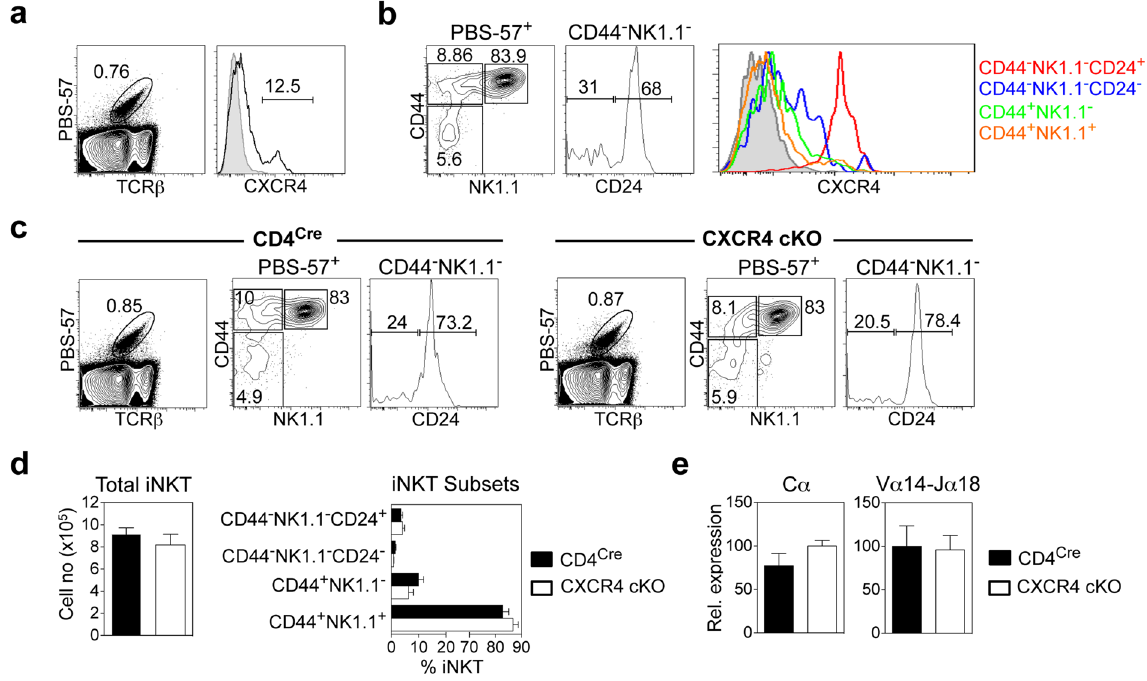
Figure 4. Intrathymic iNKT cell Development In CXCR4 cKO Mice. ( a ) Representative expression of CXCR4 by PBS-57 + CD1d-restricted thymocytes from WT mice. ( b ) Representative expression of CXCR4 by populations of PBS57 + thymic iNKT cells, defined as CD44 − NK1.1 − CD24 + , CD44 − NK1.1 − CD24 − , CD44 + NK1.1 − , and CD44 + NK1.1 + . Grey histograms show isotype control staining for CXCR4. ( c ) FACS analysis of total and iNKT cell subsets in control CD4 Cre and CXCR4 cKO mice. ( d) Quantitation of total and iNKT cell subsets in control CD4 Cre and CXCR4 cKO mice. ( e) TCR V α 14-J α 18 rearrangements in PBS-57 + depleted DP thymocytes